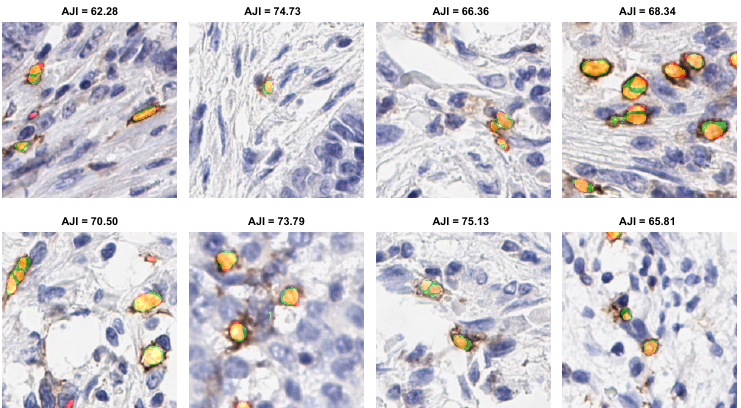
Figure 4. Illustration of proposed model segmentation result. Color maps shows the following description: orange/yellow (true positive), green (false positive), and red (false